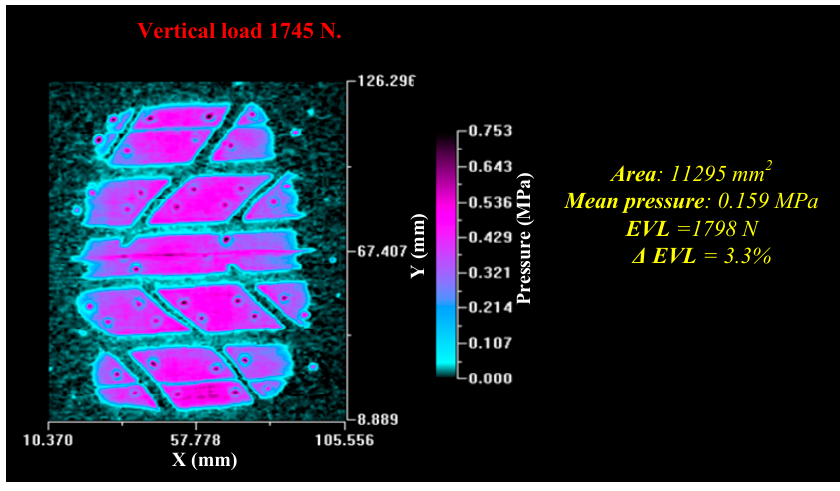
Figure 32. Static tire patch.